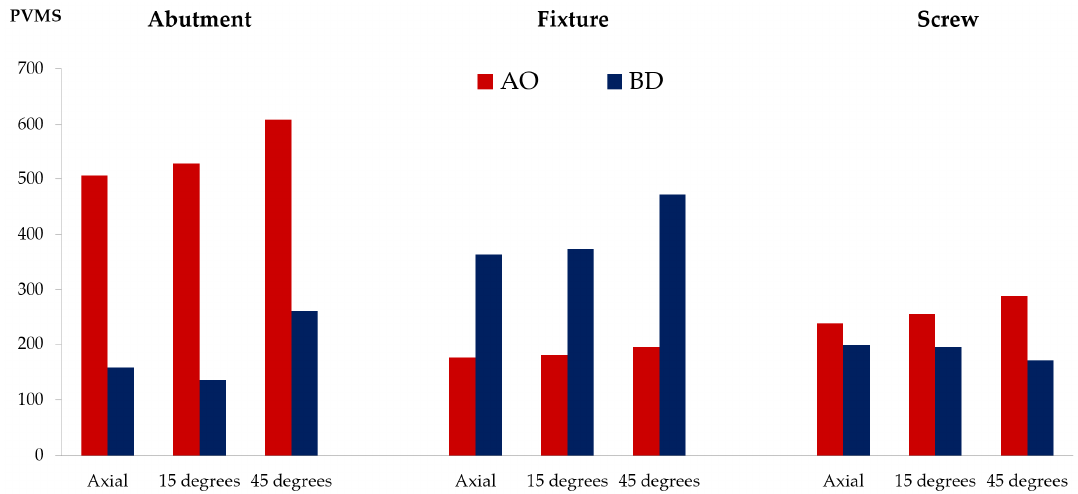
Figure 6. Peak von Mises stress results of the abutment, fixture and screw.